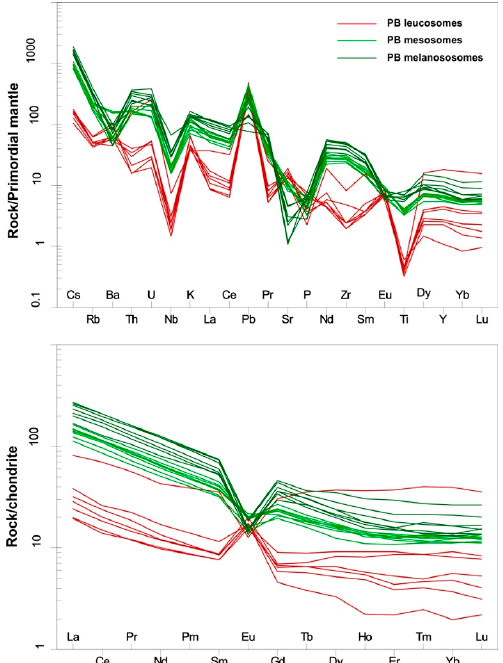
Figure 7. Primitive mantle-normalized trace element patterns and chondrite-normalized rare earth element (REE) patterns for the studied migmatitic rocks. Normalization values are from Sun and McDonough (1989) [70] for primitive mantle and from Boynton (1984) [71] for